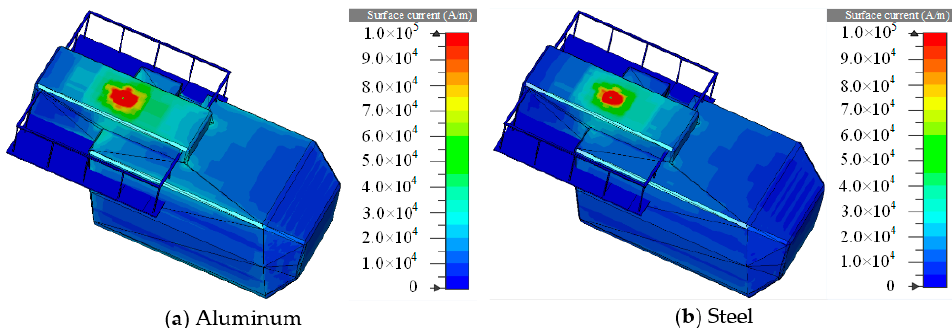
Figure 7. The distribution of surface current on the nacelle with two shielding materials during a lightning